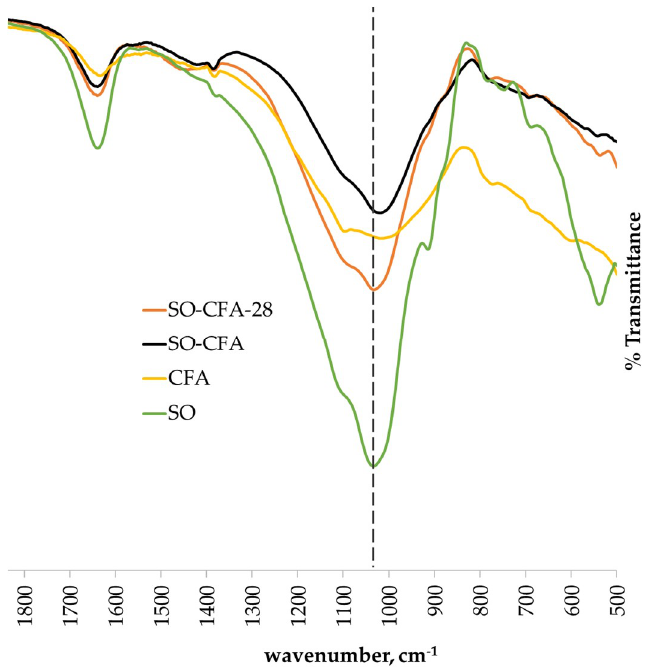
Figure 5. FTIR comparative analysis of raw materials and soil-fly ash geopolymer cement.